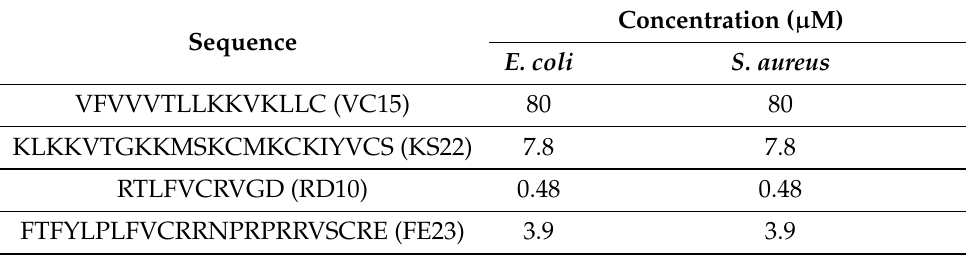
Table 9. Inhibition in Bacterial Growth. Peptides’ concentration ( µ M) that have inhibitory effects on bacterial